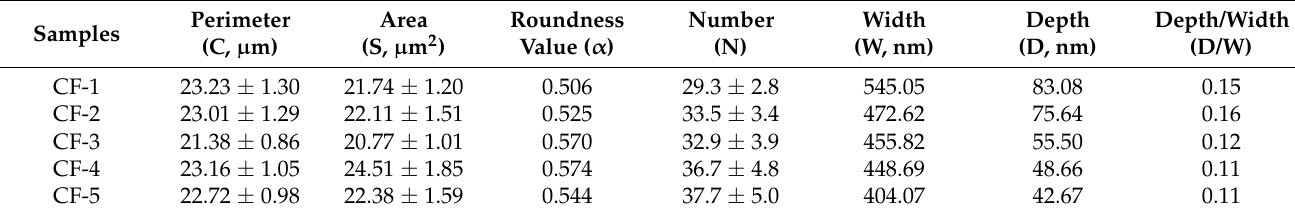
Figure 4. The cross-section grey image of: ( a1 ) CF-1, ( b1 ) CF-2, ( c1 ) CF-3, ( d1 ) CF-4, ( e1 ) CF-5; the binary image of ( a2 ) CF-1, ( b2 ) CF-2, ( c2 ) CF-3, ( d2 ) CF-4, ( e2 ) CF-5; the tangent image of: ( a3 ) CF-1, ( b3 ) CF-2, ( c3 ) CF-3, ( d3 ) CF-4, ( e3 ) CF-5. Table 2. Surface microstructure parameters of 5 types of CFs.